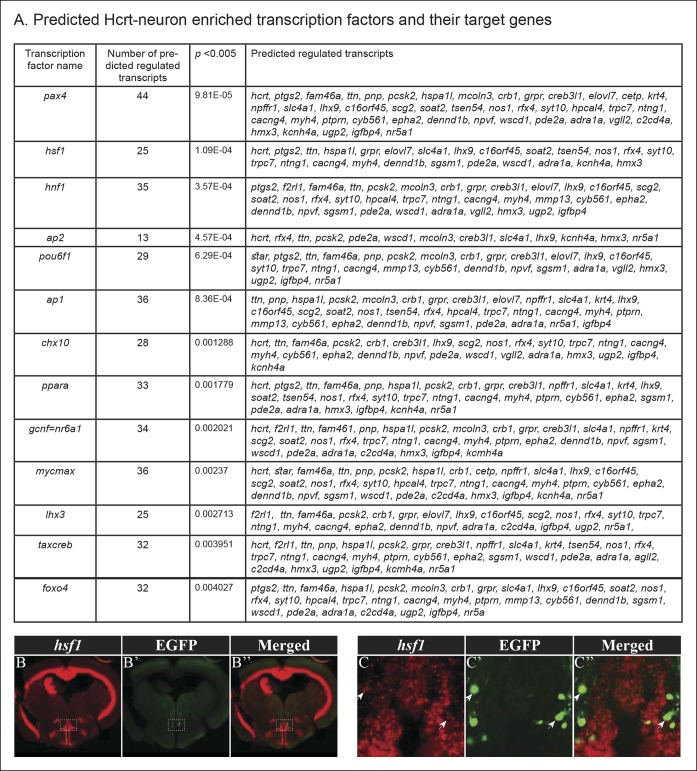
Predicted TFs that regulate the expression of Hcrt-neuron–specific transcripts.(A) TFs with a p <0.005 and their target Hcrt-neuron–specific genes. For each of these transcription factors, a combined score for each gene is calculated according to all of the predicted binding sites in its promoter. Therefore, a gene with an overrepresented binding site of a TF will have a high score for that TF and a lower p value. (B–C'') Double fluorescent ISH of hsf1 and immunofluorescence staining of EGFP in hcrt:EGFP adult brain section. Single plane (0.5 µM width) view of the Hcrt-neuron region (C–C''). Arrows mark representative EGFP and hsf1 co-expressing cell.DOI:
http://dx.doi.org/10.7554/eLife.08638.00810.7554/eLife.08638.009Figure 5—source data 1.Predicted Hcrt-neuron enriched transcription factors and their target genes.